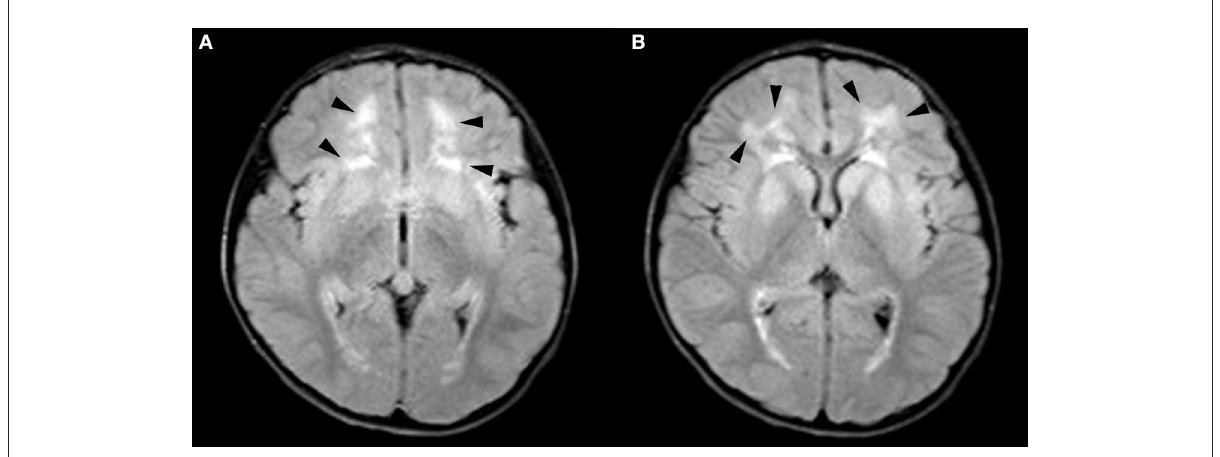
FIGURE1 Brain magnetic resonance imaging (MRI): (A) Bilateral subfrontal cortex and (B) bilateral paraventricular abnormal signals, as displayed by the arrow.